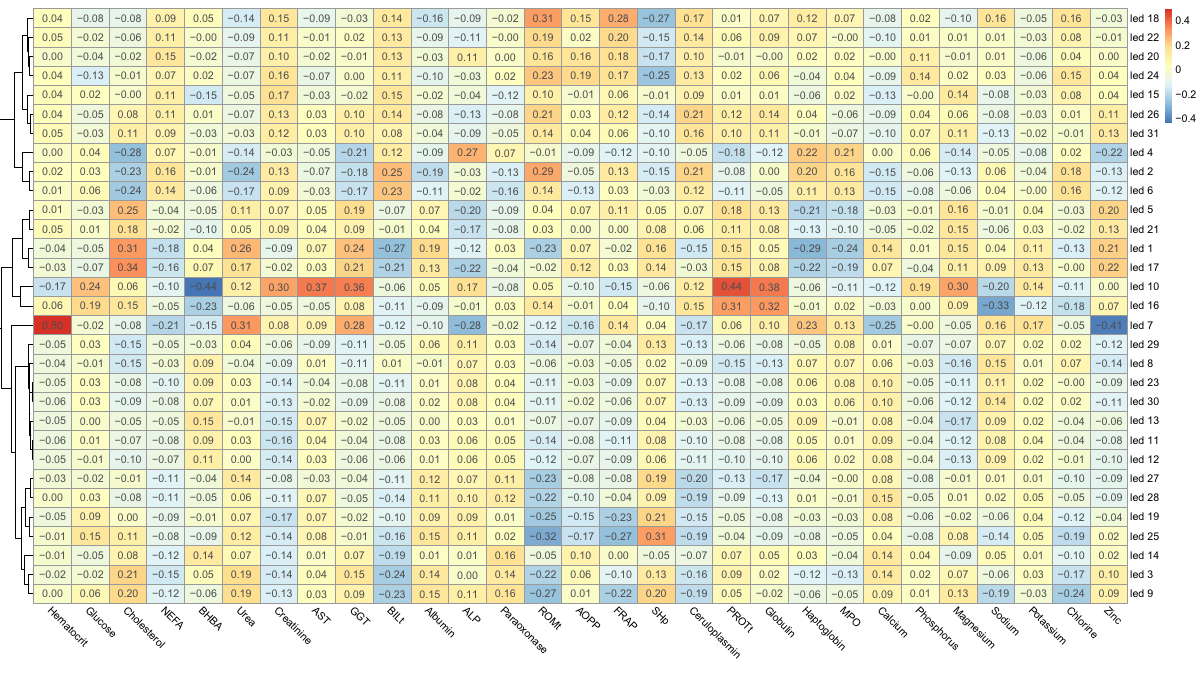
serum, and they not only correlate with increased plasma activity, but also with stage of lactation, seasonality, milk yield, and mammary gland health 60,61 . In any case, a relationship between energy metabolism and aspartate hepatic lesions showing an increase in enzymes in both matrices 61–63 . Therefore, the potential to properly predict hepatic enzymes from milk on a daily basis deserves further investigation. Blood indicators of oxidative stress were found to be reasonably predictable from milk NIR spectra, with total reactive oxygen metabolites (ROMt), ferric reducing antioxidant power (FRAP) and thiol groups (SHp) showing r values between 0.57 and 0.60. The LED 25 was the most informative for this group of traits (Supple- mentary Fig. S3). Parameters that measure oxidative stress conditions have not previously been predicted using infrared spectroscopy techniques. Plasma levels of ROMt indicate free radical production; conversely, total SHp of plasma are considered a significant element in the extracellular antioxidant defense system against oxidative stress and can be used to describe antioxidant potential in dairy cows 64 .Total reactive oxygen metabolites and SHp are present in milk 65 , and SHp can be detected by NIR spectra wavelengths 66 . Information on the relation- ship between the blood levels of oxidant/antioxidant metabolites and milk concentrations is scarce, but suggests there is a relationship between oxidative status and innate immune status in blood and milk 67,68 . The ability to predict the oxidative status of cows from milk NIR spectra might shed light on the overall stress conditions of each animal, but further research is needed to understand whether the levels of oxidative stress metabolites in milk are representative of blood concentrations. With regard to blood indicators of inflammation and innate immunity, prediction accuracies were low for ceruloplasmin and myeloperoxidase, but were better for haptoglobin, total proteins and globulins ( r = 0.66, 0.57, and 0.61, respectively). The LEDs providing most information on these traits are 7, 10, 13 and 16 (Supplementary Fig. S4). Haptoglobin is an acute-phase protein and is a sensitive indicator of local or systemic inflammation, which can occur prior to the development of typical signs of inflammation (e.g. inflammatory leucogram) 69 . It